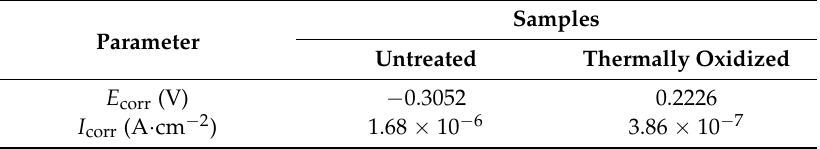
Table 2. Parameters obtained from potentiodynamic polarization curve in Figure 3.